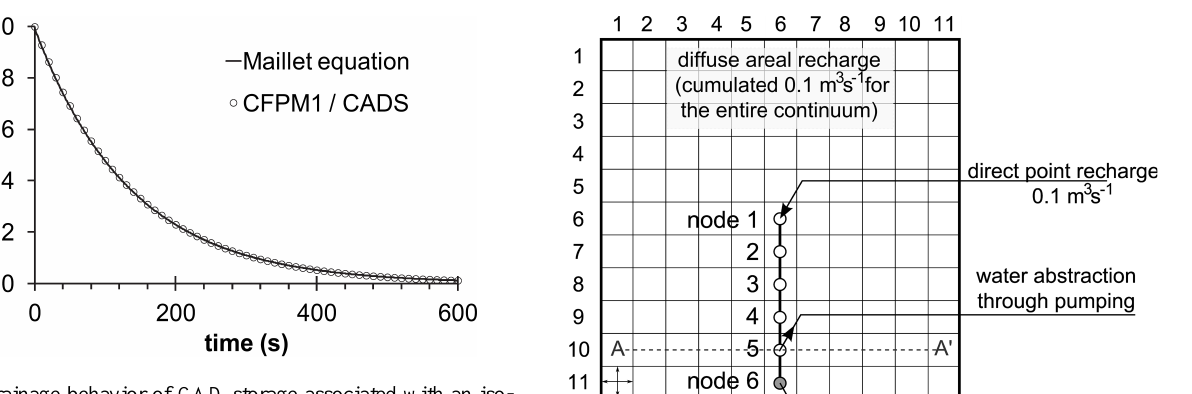
Fig. 4. Drainage behavior of CAD storage associated with an iso- lated conduit to verify the CADS implementation in CFPM1.